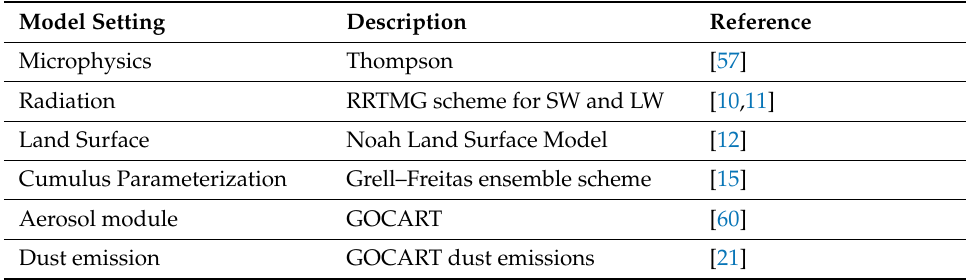
Table 1. Configurations of the model used in the